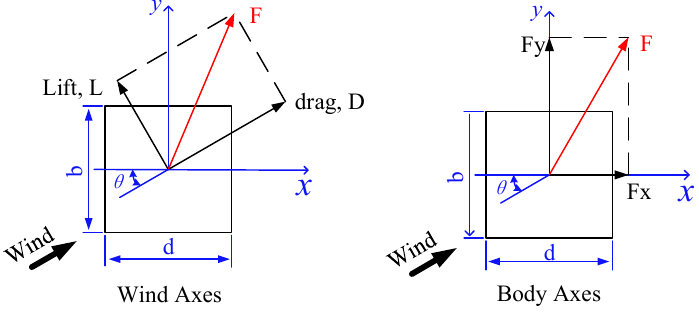
Figure 8. Wind force components of a square prism [37]